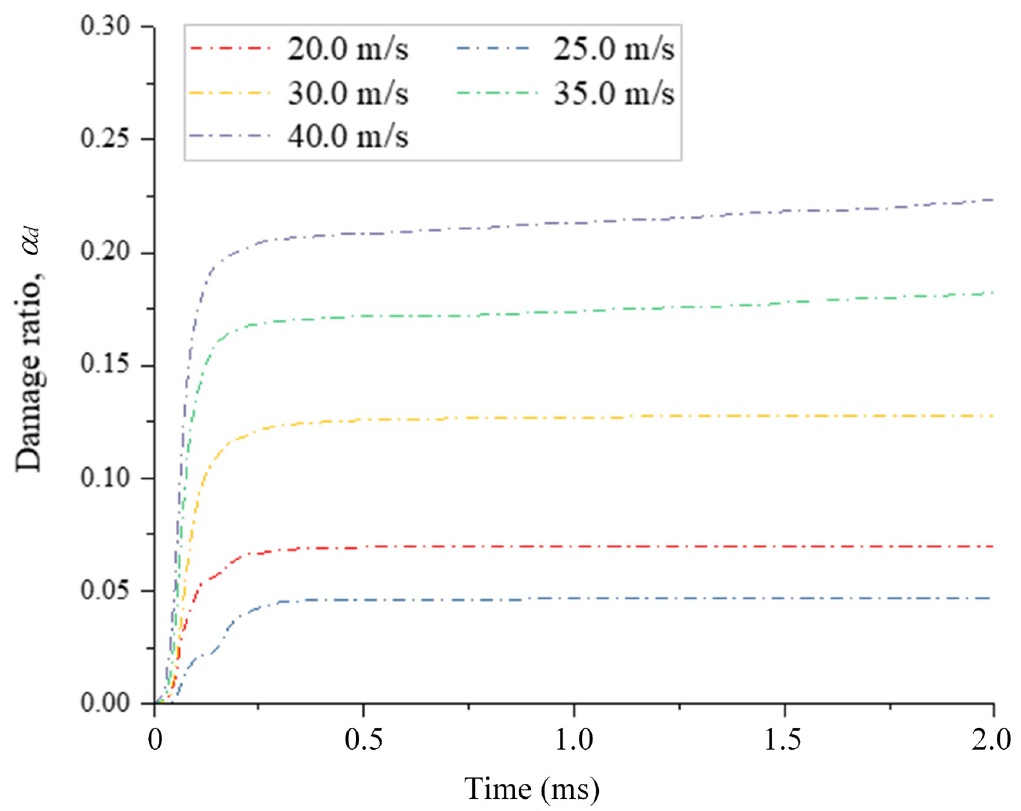
Fig 15. Evolution of the damage ratio ( α